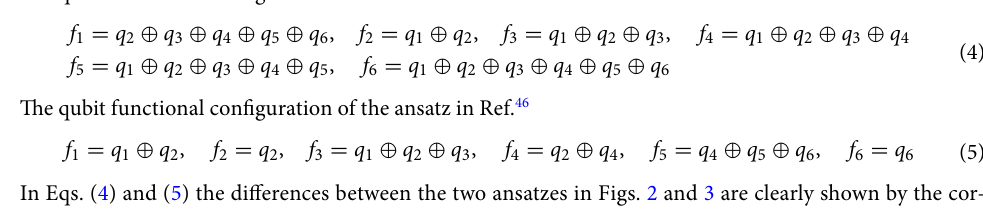
Figure 1. Graphical illustration of an arbitrary quantum circuit analyzed with multiple layers of qubit functional configurations. Note here we use the symbol U k to mean “any 1-qubit gate on the k not a particular gate and may represent different 1-qubit gates across different layers.